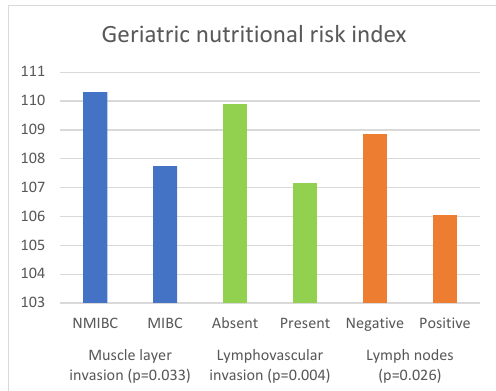
Figure 7. Significant associations of geriatric nutritional risk index ratio with histopathological characteristics of bladder cancer.